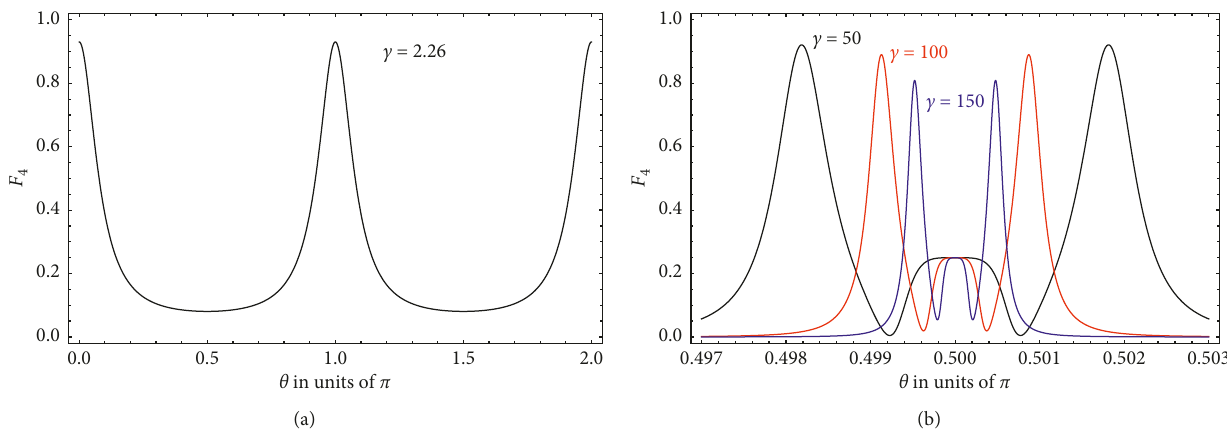
Figure 4: The fidelity plots for 4-NOON states. (a) The fidelity of interferometer state’s N photon component with NOON state with N � 4 for weak fields. The horizontal axis is the phase of the coherent field. The phase of PDC is chosen to be zero. Here, the gain parameter of the � 93 . 3%. The maximum fidelity is PDC is r � 0 . 1 and the amplitude ratio is optimized at c � | α | 2 / r � 2 . 26 for the maximum fidelity of F 4 reached at phases of 0 and π . This is much better than the case (with down-converted photons only) with a fidelity of 75% and the case (coherent fields only) with a fidelity of 50%. (b) The fidelity profile in the limit of high gain with r � 4 . 5 (this gain has been reported in [30]). The black, red, and blue curves are with fidelities of 92%, 90%, and 81%, respectively. It is clear from the plots that we have much more flexibility in pair amplitude ratio. By choosing a larger amplitude ratio, we can reach a total flux of coherent state pair photons having approximately 3 orders of magnitude higher than PDC pair